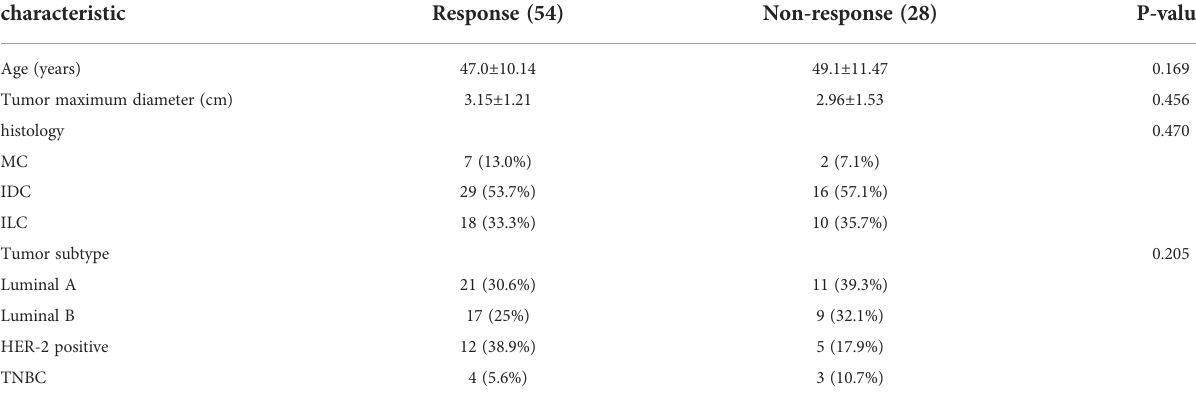
TABLE 1 Clinicopathological features of the patients at baseline.